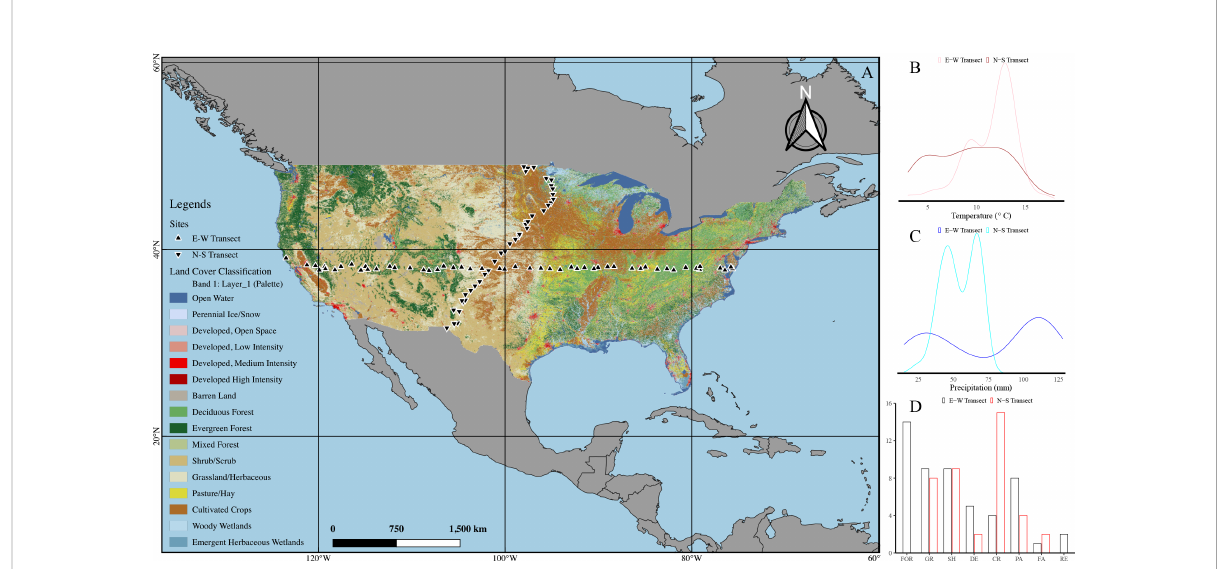
FIGURE 1 Location of soil sampling sites along North-South and East-West transects of continental United States. The transects are grouped into sub- continental regions (A) as shown in circles along mean temperature (B) and mean annual precipitation (C) . The number of stations where data was collected well represent the vegetation types of the continental United States (D) . The legend color shown at the right corresponds to the color of the circles on the maps. Black triangles represent the sampling sites. FOR, evergreen or mixed forest; GR, grassland/herbaeous; SH, shrubland; DE, decidous forest; CR, small grains or crop; PA, pasture/hay; FA, fallow; RE, low intensity residential. Map was generated using QGIS (3.2.2). Map data source: National Land Cover Database (2011) from